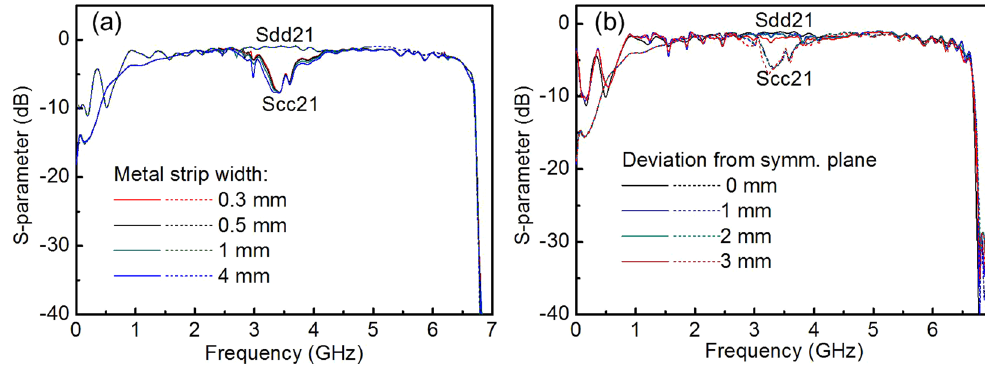
Figure 6. The influence of fabrication mismatch on the S-parameters caused by (a) the metal strip width and (b) the location